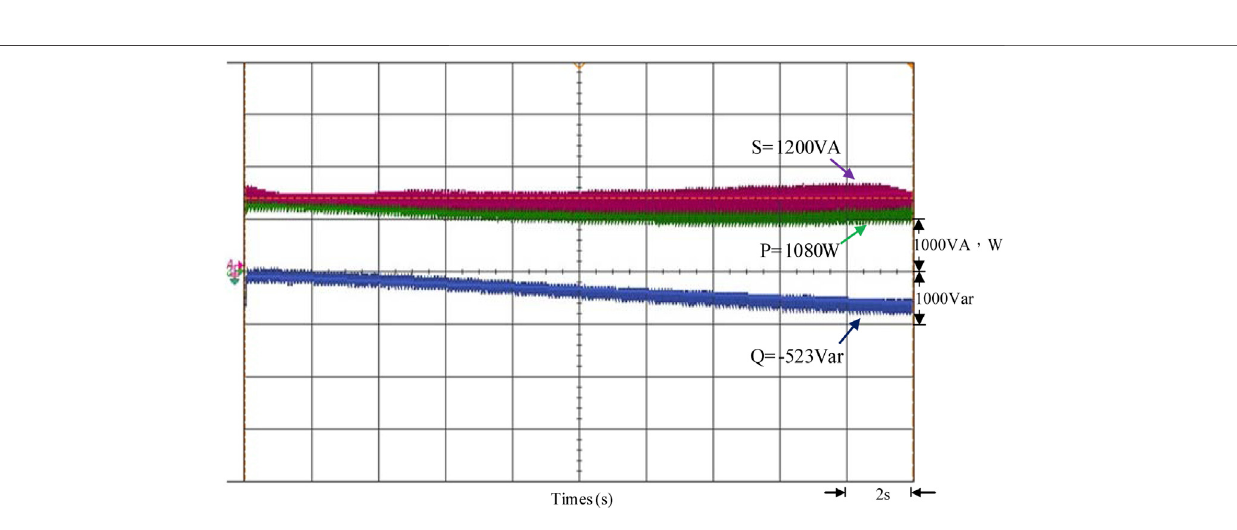
Frontiers in Energy Research |